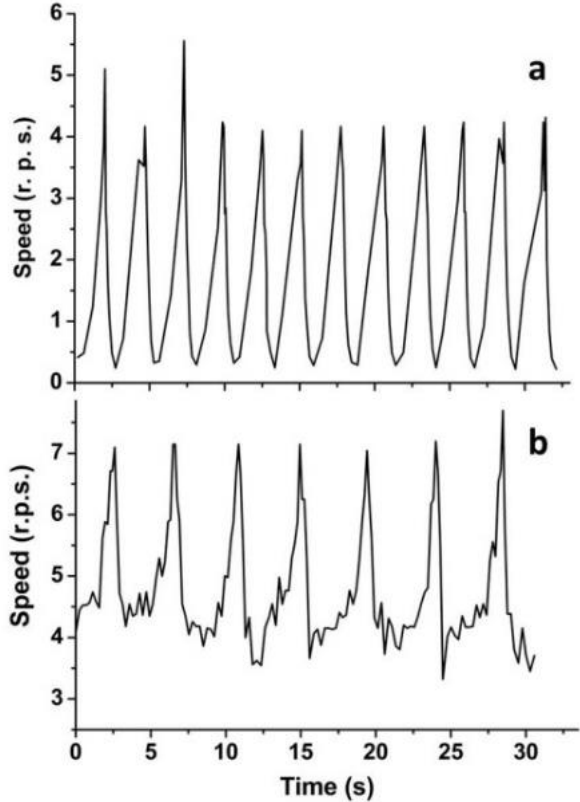
Figure 3. Time dependence of the speed of pulsed rotation for liquid marbles with different weights: ( a ) 6.5 mg; ( b ) 14.5 mg.